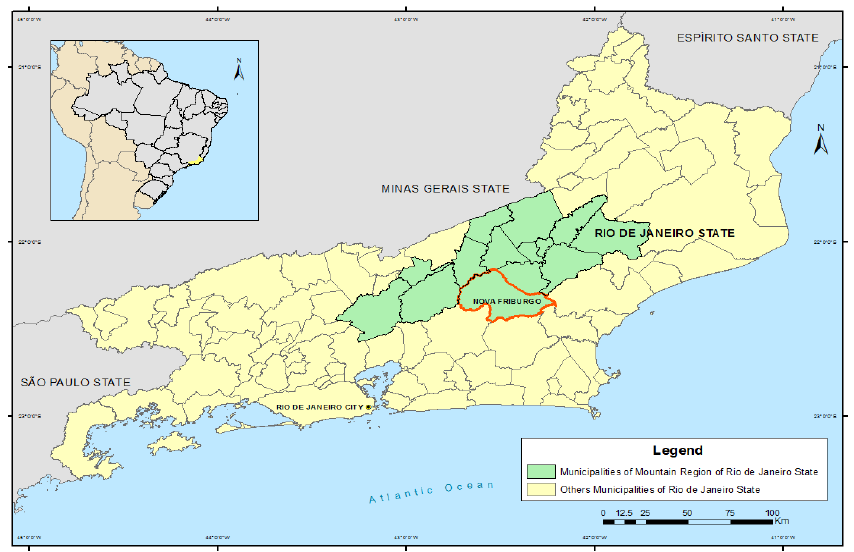
Figure 1. Location of municipalities in the Mountain Region of Rio de Janeiro State (Brazil). Highlight for Nova